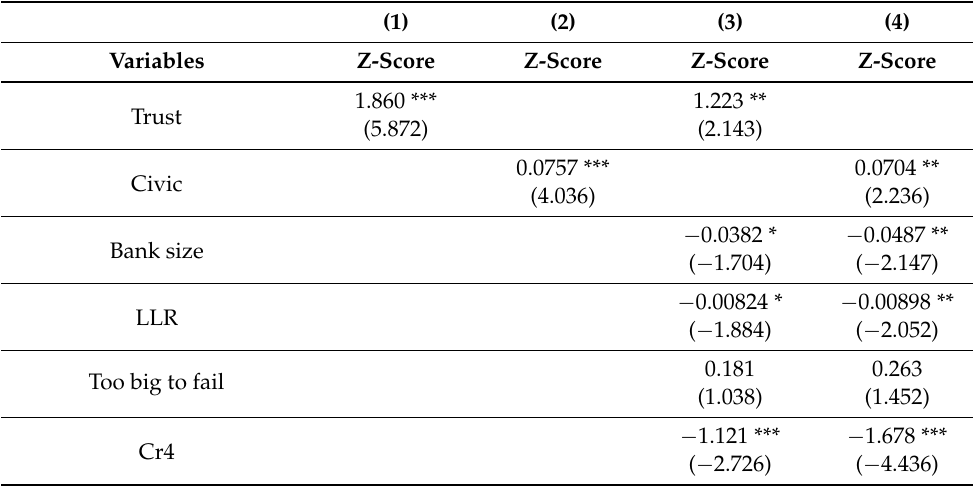
Table 6. Robustness checks: Excluding